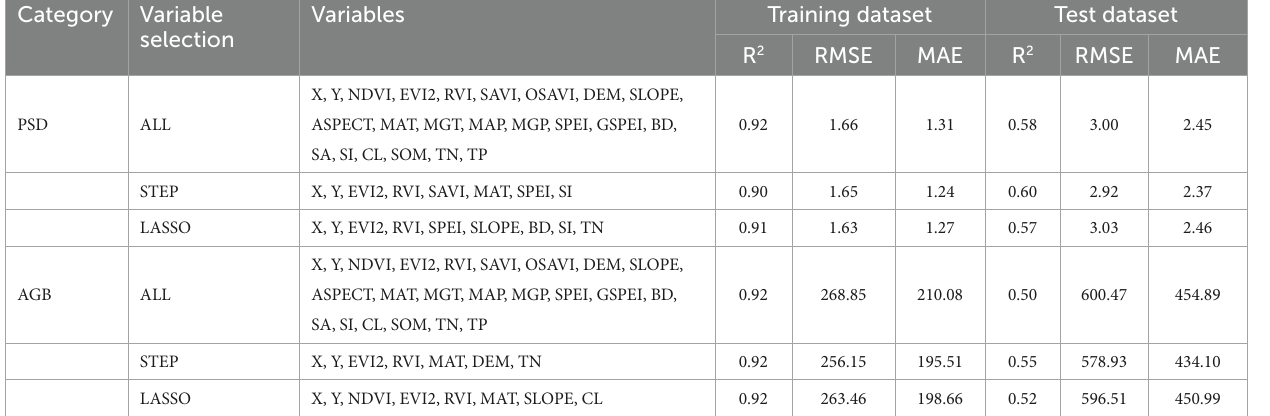
TABLE 2 Results of variable selection and evaluation of model accuracy. Category Variable